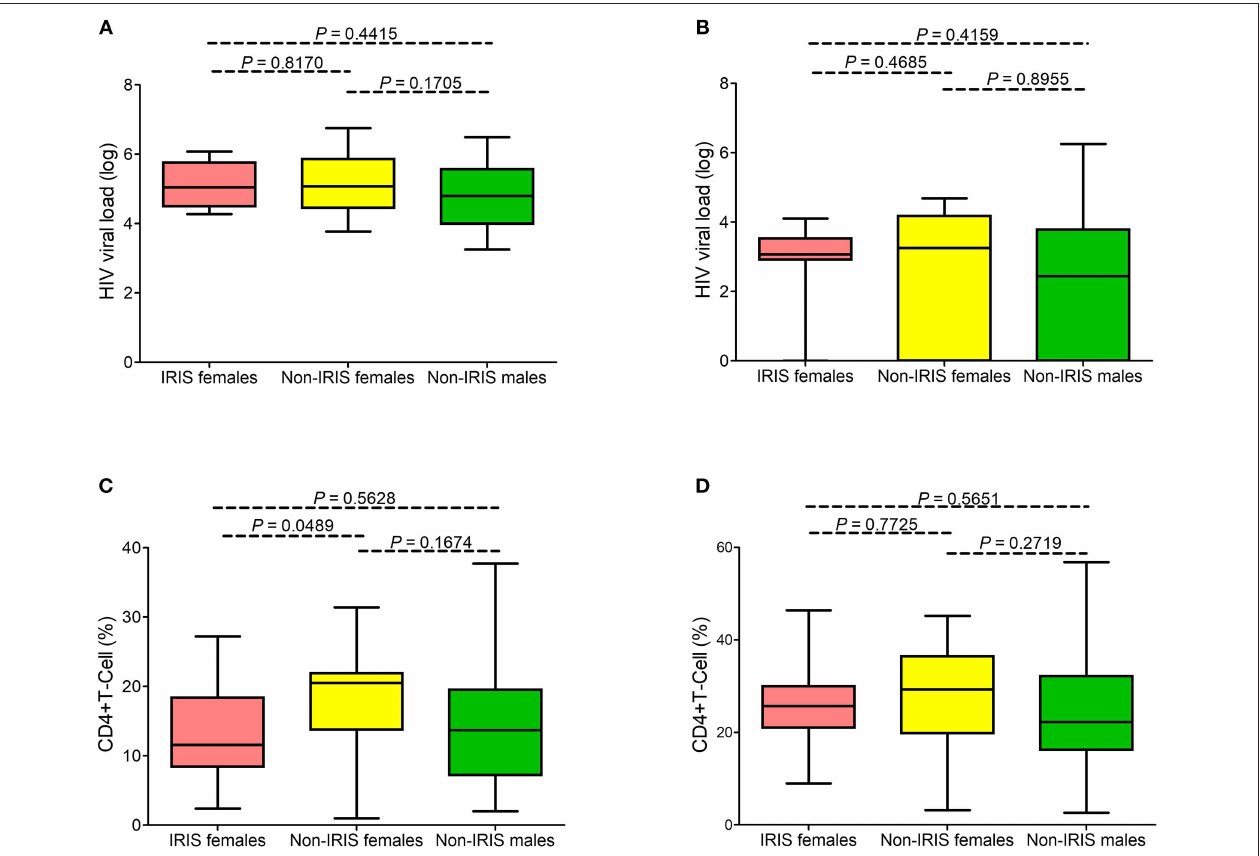
FIGURE 1 | Virologic and immunology profiles in the Brazilian pediatric HIV cohort. No statistical difference was observed between viral loads before (A) and after ART (B) in females presenting with IRIS-related infectious events (represented in pink), females with no IRIS events (yellow), and males (green). Females presenting with IRIS infectious events exhibited lower CD4 cell percentages before (C) but not after ART (D)